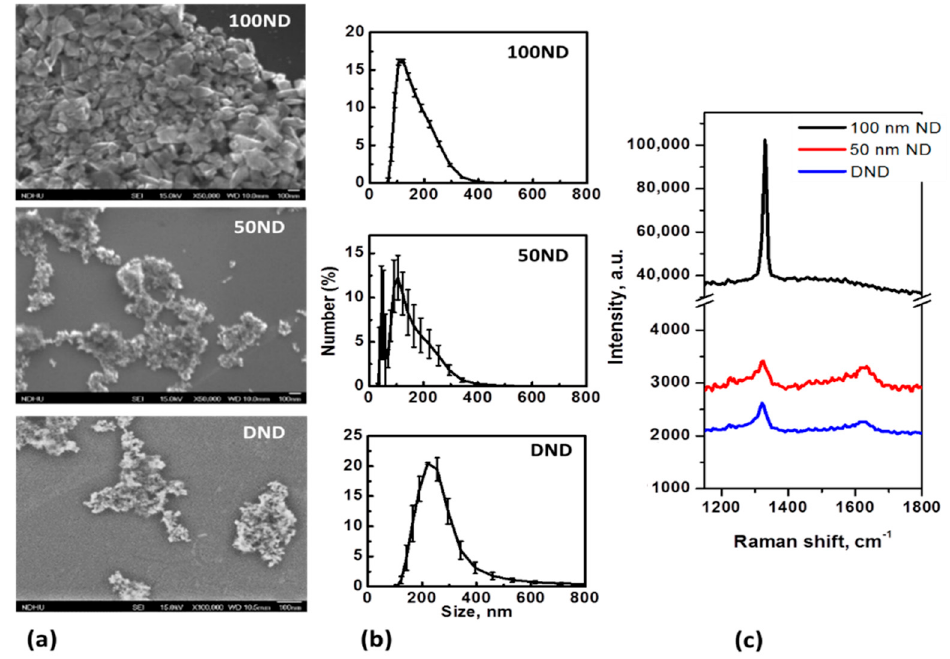
Figure 1. Nanodiamond (ND) characterization: ( a ) SEM images of NDs dried on an Si substrate; ( b ) size distributions in a water suspension and ( c ) Raman spectra of NDs (on Si substrate).